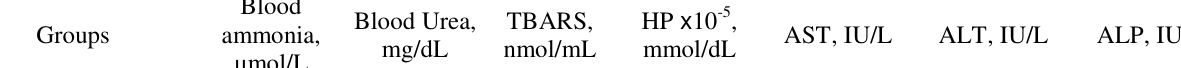
Table 2. Effect of W. somnifera on changes in the blood ammonia, plasma urea, TBARS, HP, serum AST, ALT and ALP of control and treated rats